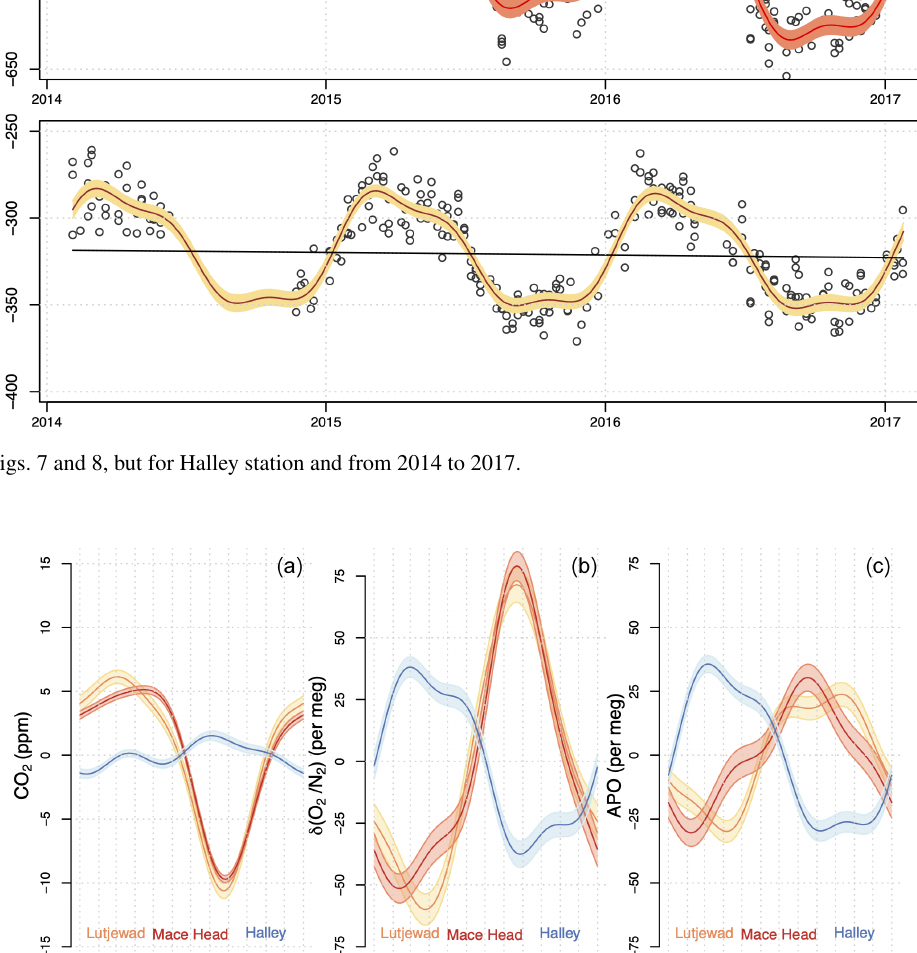
Earth Syst. Sci. Data, 14, 991–1014, 2022